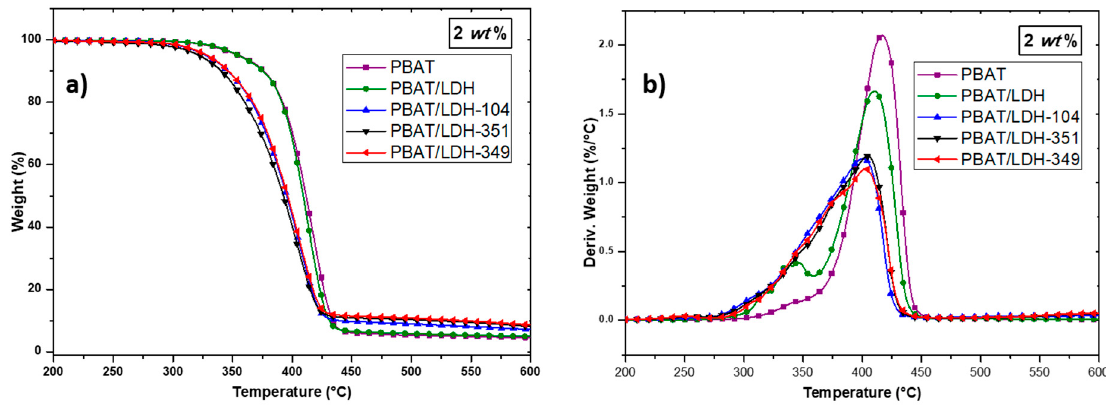
Figure 4. Evolution of weight loss obtained by TGA ( a ) and DTG ( b ) of the neat PBAT and PBAT-LDH (2 wt %) nanocomposites (heating rate 20 K · min − 1 under nitrogen flow).